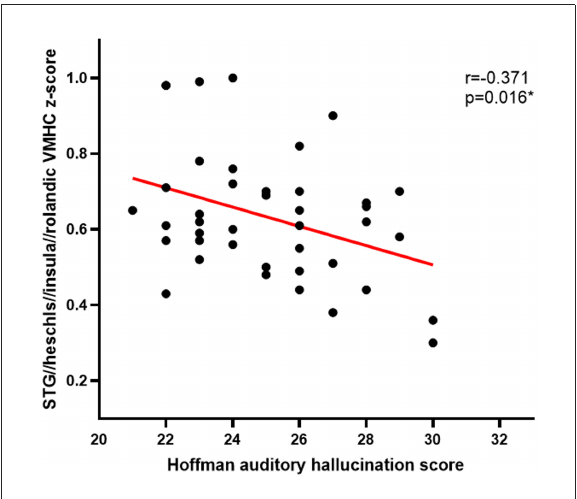
FIGURE3 The Hoffman score was negatively correlated with the VMHC in the STG cluster in APG ( p <